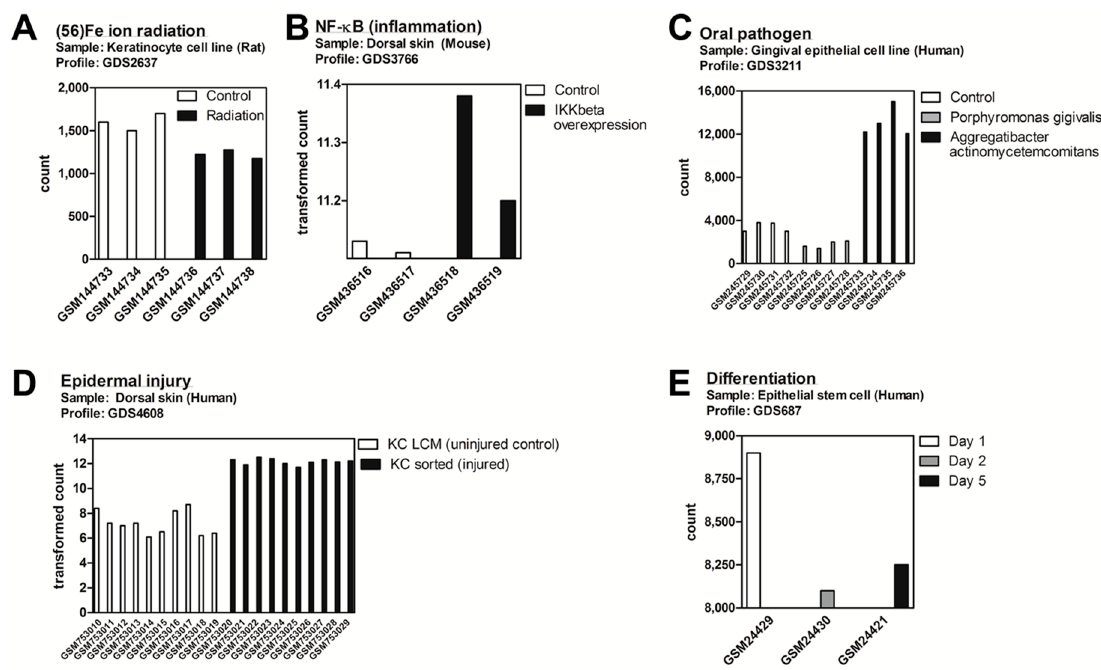
Figure 1. Gene Expression Omnibus (GEO) profile assessment of Ddit4 / DDIT4 responses to biological and stress conditions within epithelial cells. (1.5 column) ( A ) For all DataSets presented in this figure, the graphs represent Ddit4 / DDIT4 transcript levels. DataSet GDS2637 shows that Ddit4 was not induced after 56FE ion irradiation within a rat keratinocyte cell line; ( B ) DataSet GDS3766 shows that NF- κ B activation by IKK β overexpression in mouse dorsal skin resulted in increased Ddit4 levels; ( C ) DataSet GDS3211 reports that periodontal pathogen infection of a human gingival epithelial cell line with Aggregatibacter actinomycetemcomitans led to DDIT4 induction; ( D ) DataSet GDS4608 shows that upon injury of human epidermal cells, DDIT4 transcript levels were increased compared to uninjured samples; ( E ) DataSet GDS687 shows that differentiation of keratinocyte stem cells upon mesenchymal-epithelial interactions resulted in decreased DDIT4 expression over time. All DataSets can be accessed at: http://www.ncbi.nlm.nih.gov/geoprofiles.